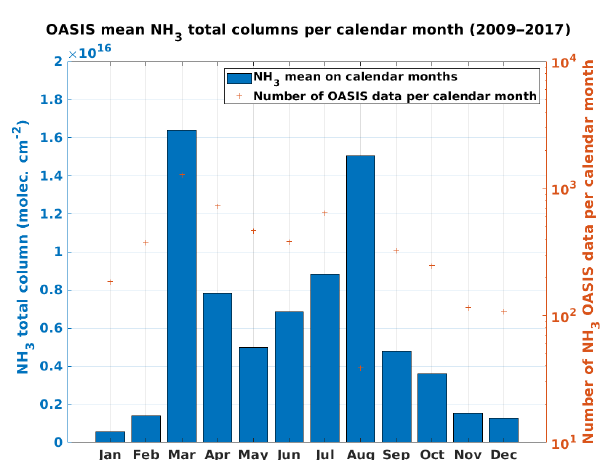
Figure 5. Average annual cycle of monthly NH 3 total columns (molec.cm − 2 ), observed by OASIS over Paris, averaged over the 2009–2017 period. The red crosses represent the number of OASIS data per calendar month on a log scale (right